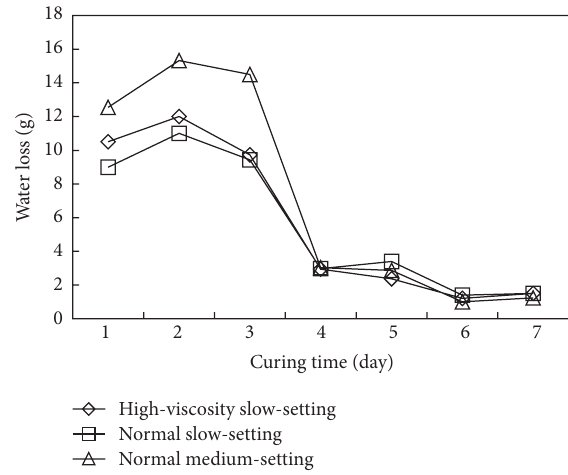
Figure 9: Water loss at different curing